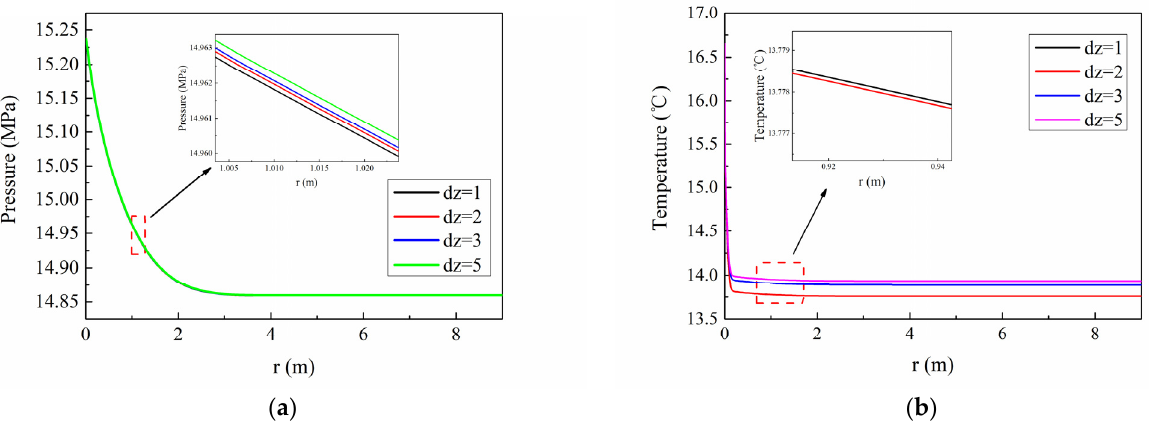
Figure A2. Comparison of the pressure and temperature distribution curves at 25 m from the bottom of the reservoir in the simulation results with vertical element spacing parameter values of 1 m, 2 m, 3 m, and 5 m: ( a ) pressure distribution; ( b ) temperature distribution.